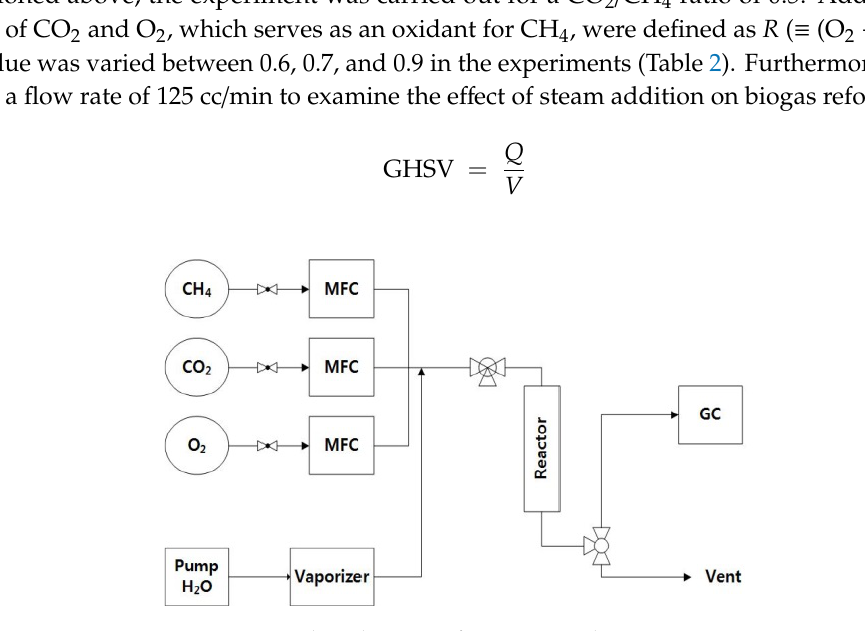
Figure 3. Flow diagram of experimental apparatus.